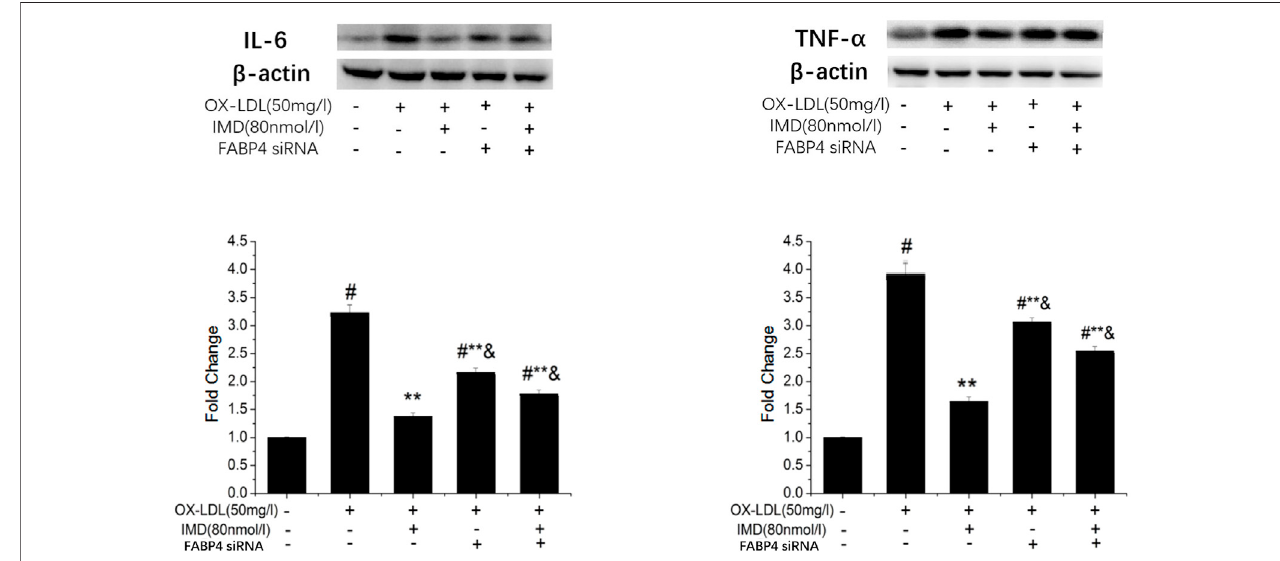
FIGURE 8 | IMD inhibits the protein expression of IL-6 and TNF- α through the FABP4 pathway. # Compared with the control group ( p < 0.05); ** compared to the ox-LDL alone group ( p < 0.05); & compared to the ox-LDL +IMD group ( p <